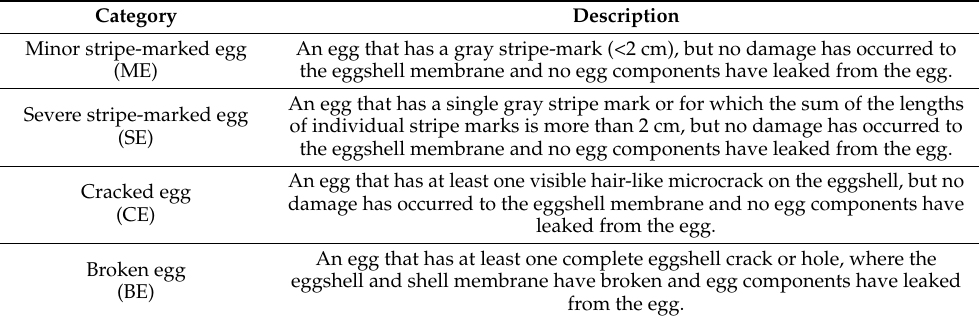
Table 1. Cracked egg types and description.